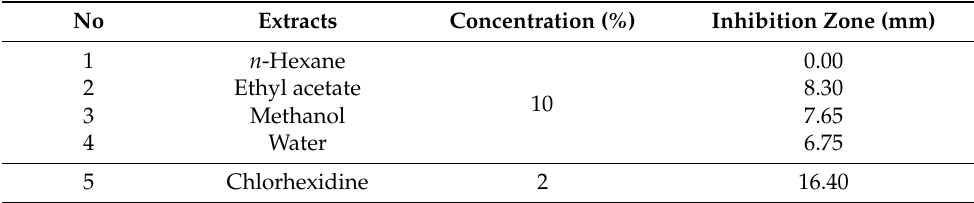
Table 1. The inhibition zones of Uncaria gambir Roxb. Extracts against E. faecalis ATCC 29212.